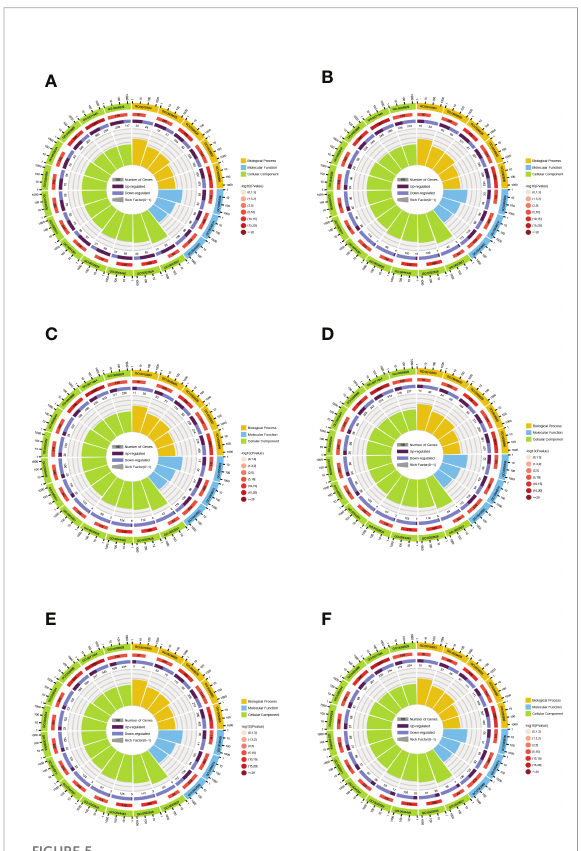
FIGURE 5 Enrichment circle plots for different comparison groups. (A) The comparison group of 0 h vs. 1 h. (B) The comparison group of 0 h vs. 12 h. (C) The comparison group of 0 h vs. 24 h. (D) The comparison group of 1 h vs. 12 h. (E) The comparison group of 1 h vs. 24 h. (F) The comparison group of 12 h vs. 24 h.